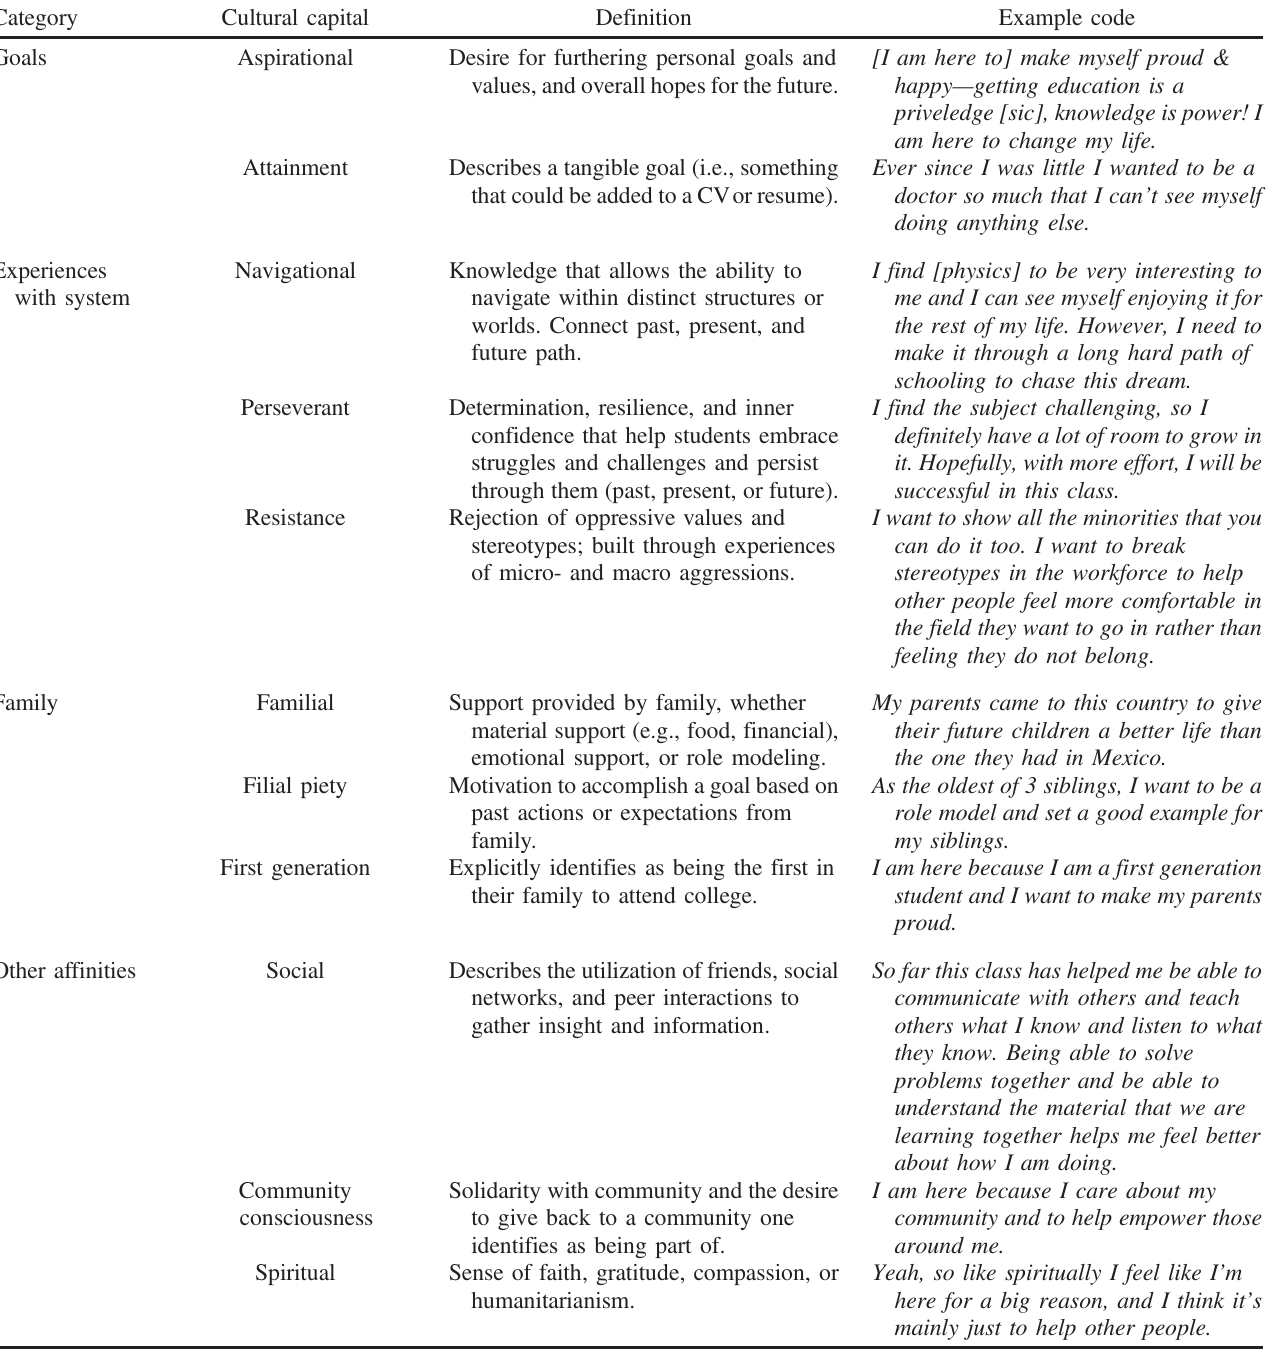
TABLE VI. Definitions and examples of cultural capitals exhibited in reflective journal essays. These cultural capitals were derived from the original community cultural wealth model by Yosso [42], the extension of the model by Kanalaga et al. [44], and emergent capitals from our